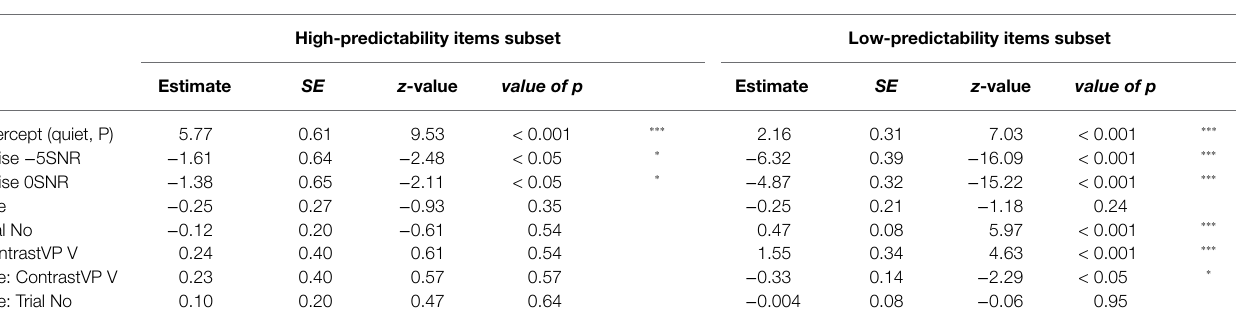
TABLE 2 | Model outcomes for high- and low-predictability